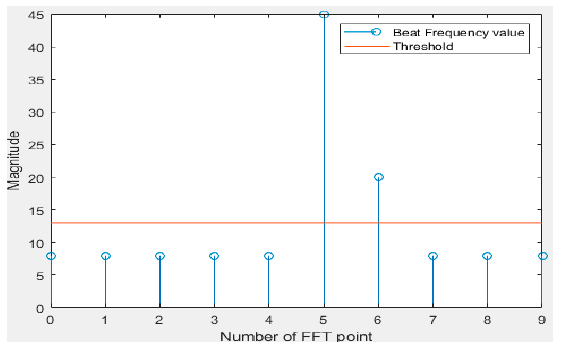
Figure 6. Example when the main lobe of beat frequency is located a few times the FFT bin.